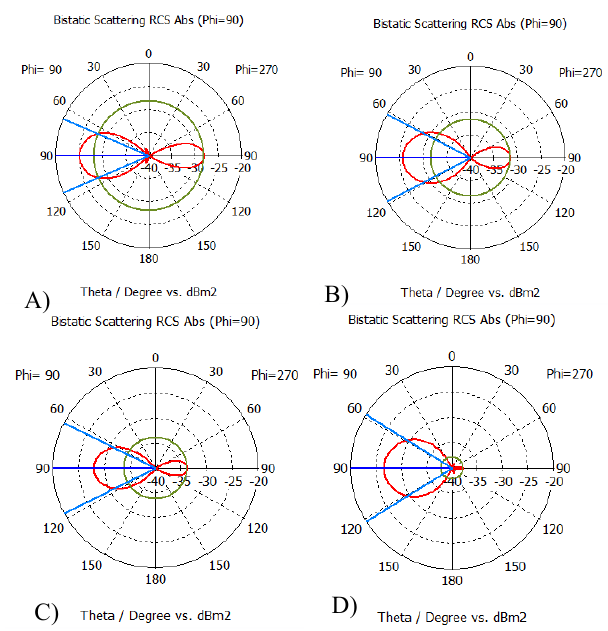
Figure 9: The far field scattering pattern a) the object without cloak. b) patch structure. c) mesh structure. d) ring